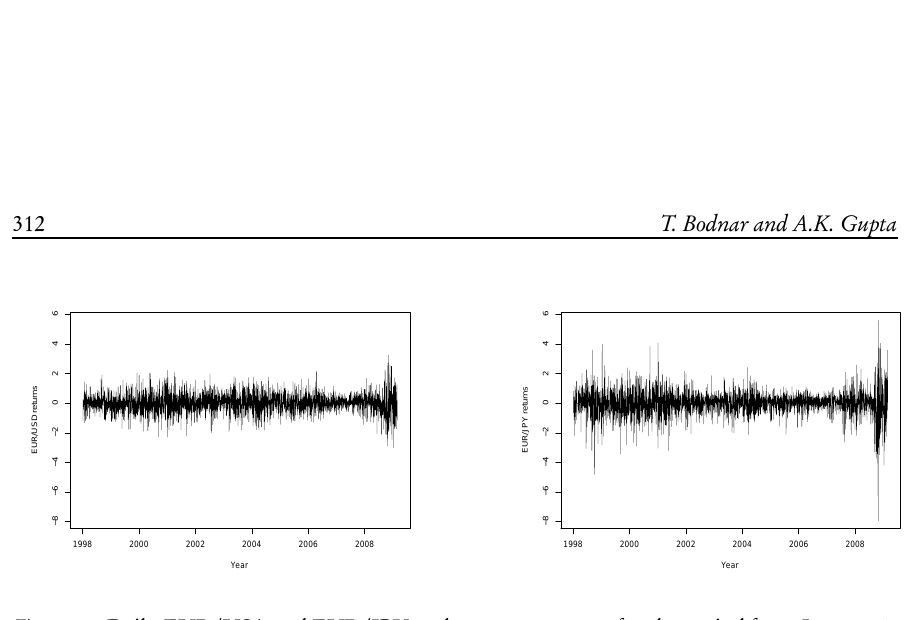
Figure 1 – Daily EUR / USA and EUR / JPY exchange rate returns for the period from January 2, 1999 to November 30,